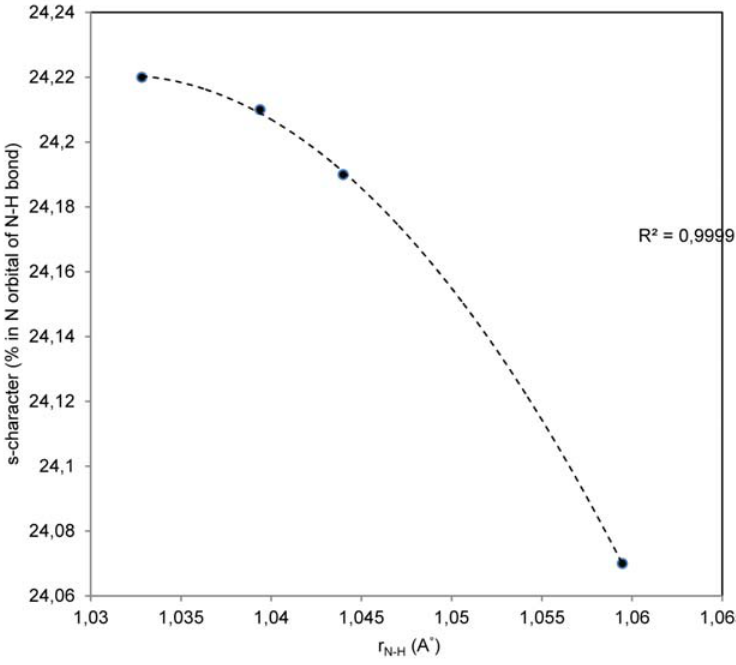
Figure 7. correlation between s-character and N-H bond length for N-H–-Cl interaction in threonine hydrochloride